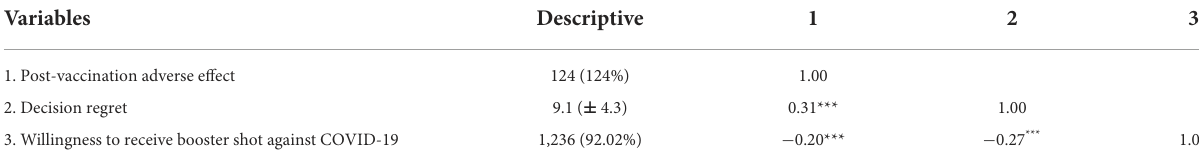
TABLE 4 Descriptive statistics and correlation among study participants.